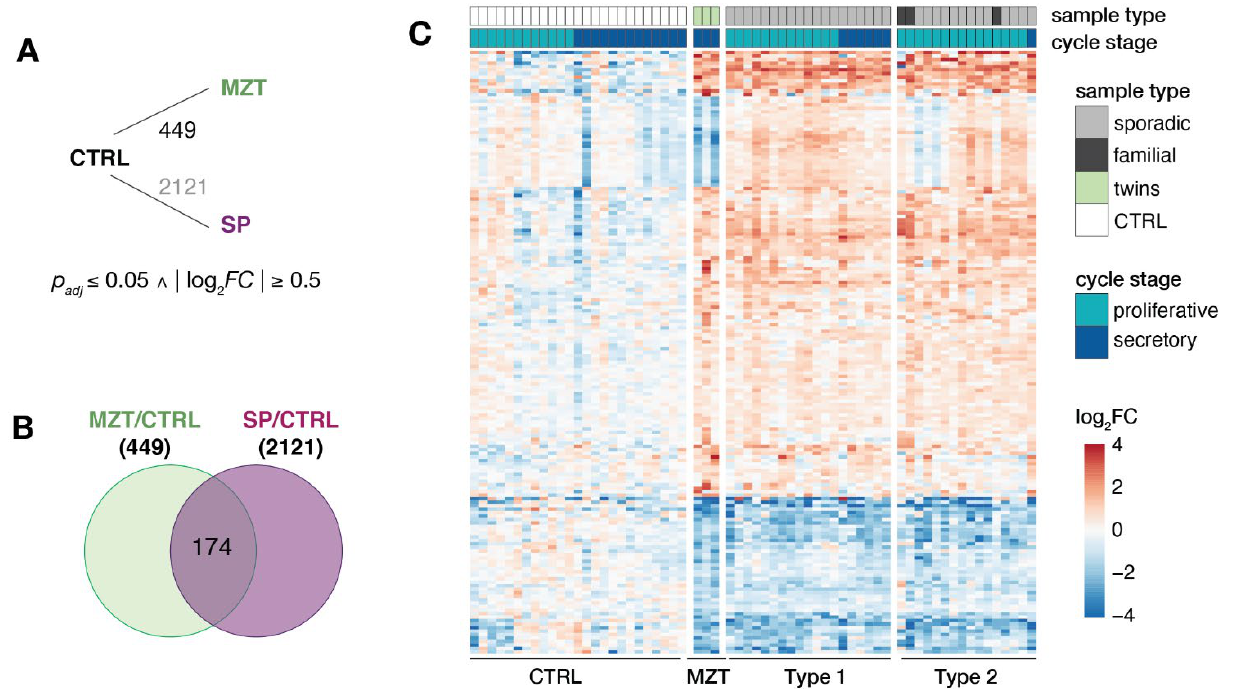
Figure 3. Endometrial transcriptomes of MRKH twins and sporadic cases show largely similar changes. ( A ) Schematic diagram of comparisons between MRKH monozygotic twins (MZT), MRKH sporadic cases (SP) and unaffected women (controls) indicating number of differentially expressed genes (DEGs). DEGs between sporadic cases and controls based on previous work [13]. Fold change and significance cut-offs below. ( B ) Venn diagram showing number of common DEGs MRKH twins and sporadic cases each compared to controls. ( C ) Expression profiles ( log 2 expression change relative to Ctrl group) of 174 DEGs (common DEGs indicated in Figure 3B) across all samples. Rows hierarchically clustered by Euclidian distance and ward.D2 method. Cycle information (proliferative or secretory) and patient type (monozygotic twin, sporadic, or control) on top.